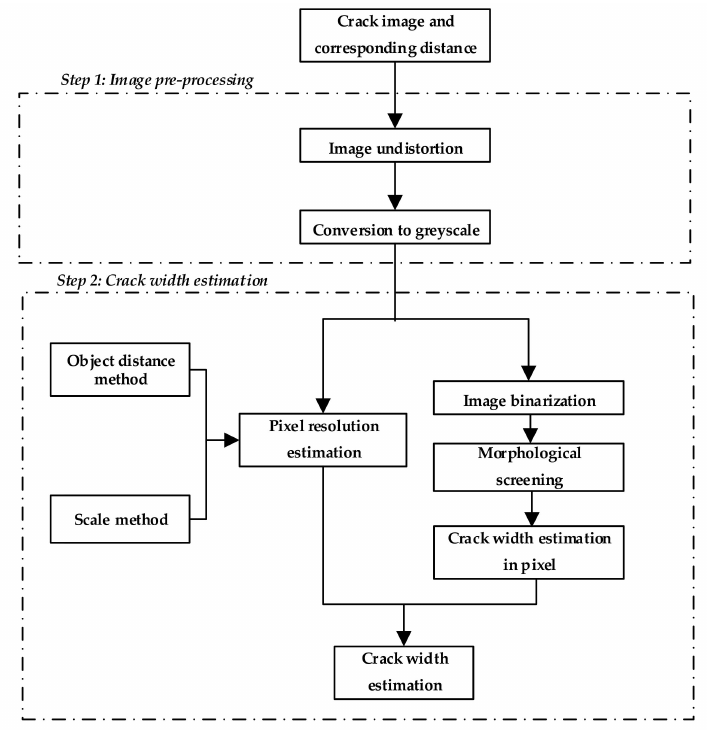
Figure 5. Flowchart of comparing the accuracy of the two